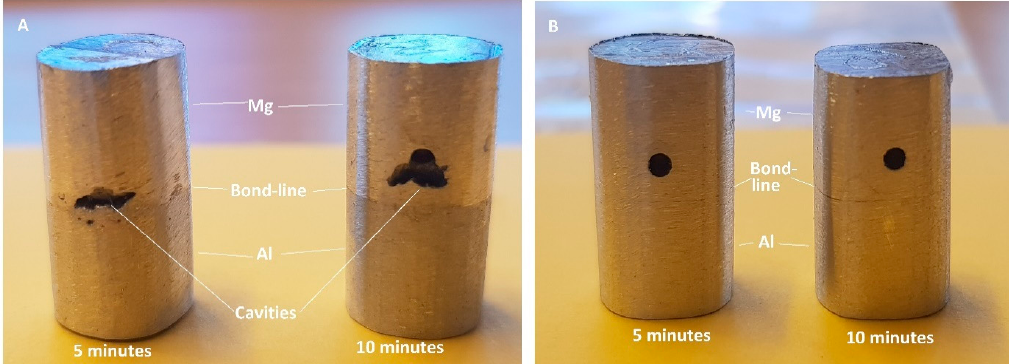
Figure 14. Bonded samples used for shear testing: ( A ) Sample bonded with Cu/Al 2 O 3 interlayer. ( B ) Samples bonded using pure-Cu interlayer.